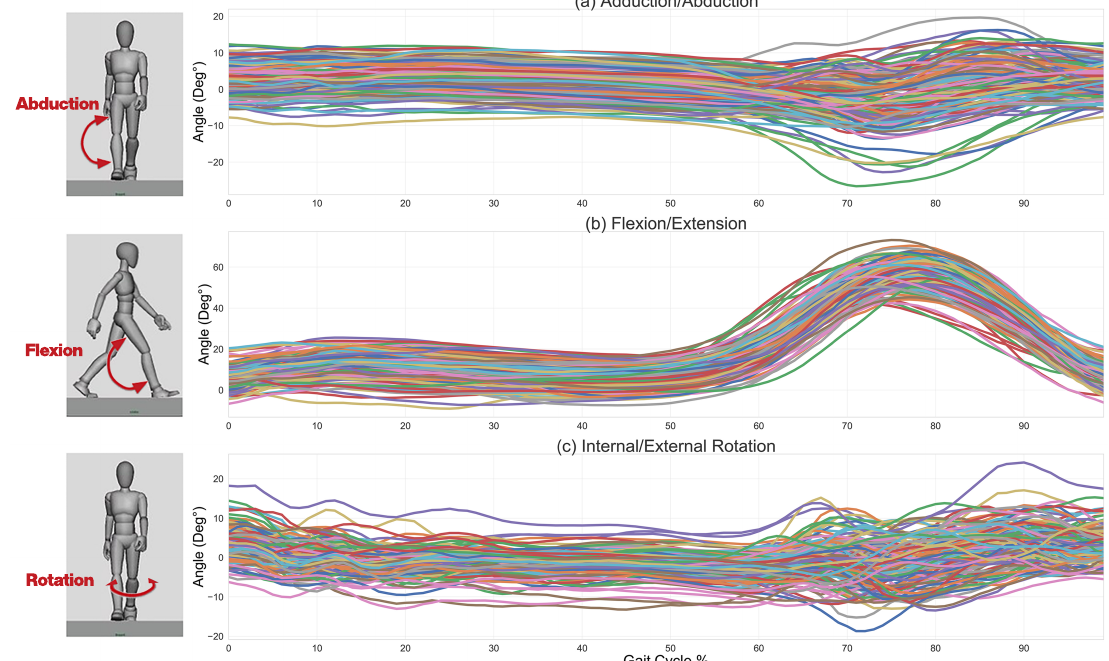
Figure 2. Knee kinematic data describe variations of knee movement in 3 dimensions during a gait cycle (1% being the initial contact and 100% is the end of a gait cycle). The 3 dimensions are ( a ) abduction/adduction in the frontal plane, ( b ) flexion/extension in the sagittal plane, and ( c ) internal/external rotation in the transverse